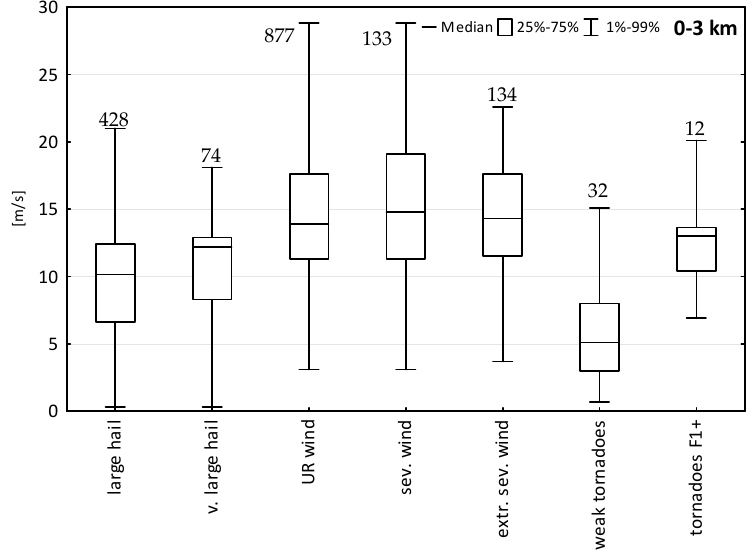
Figure 4. As in Figure 2, except for the 0–3 km bulk wind shear.